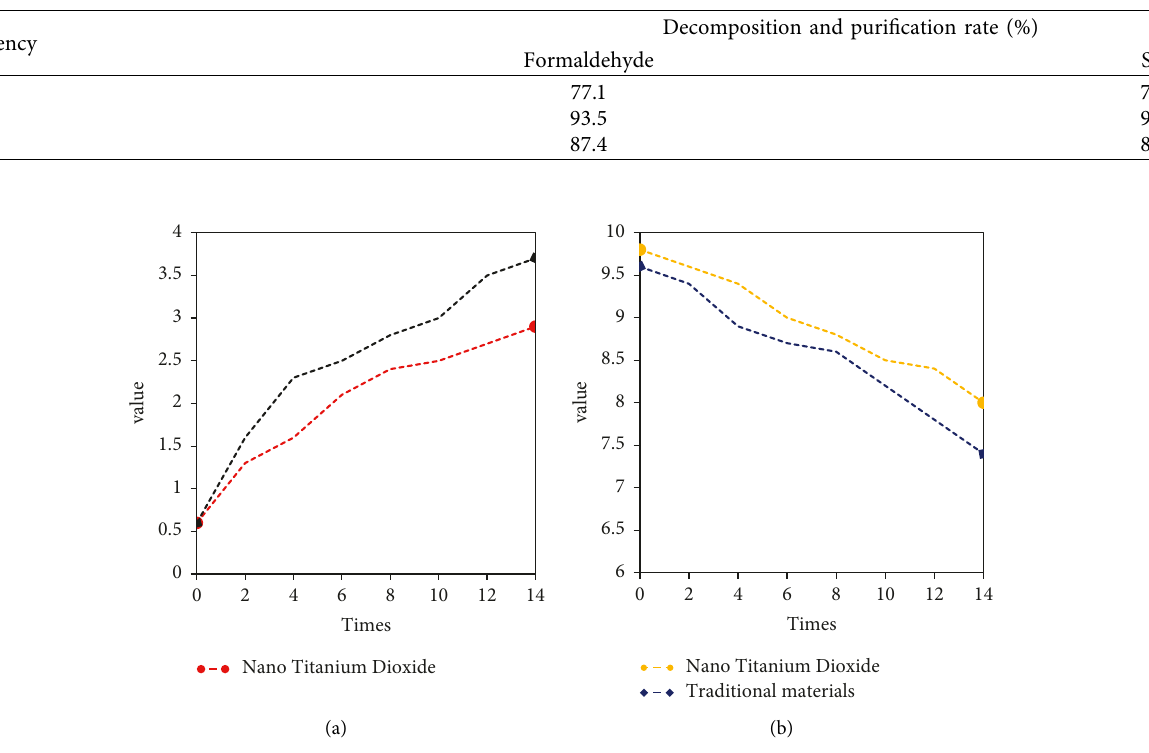
Figure 5: Indoor photocatalytic effect of nanometer titanium